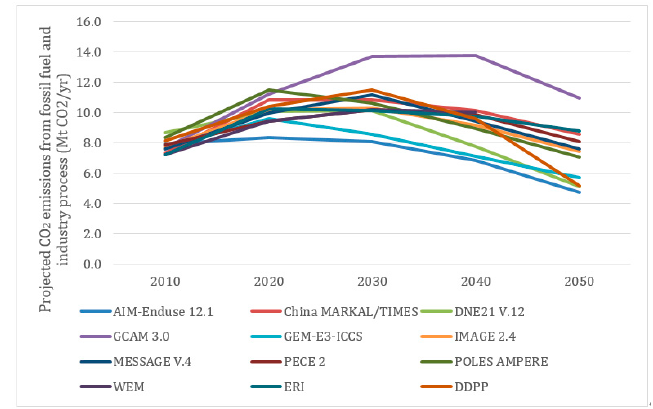
Figure 2. China’s CO 2 emissions, 2010–2050, projected by Alternative Scenarios. Source: See Table A1 for data sources for each